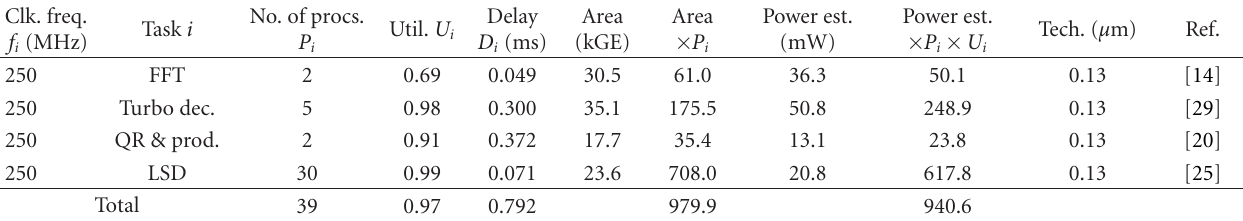
Table 1: The baseband processing chain with TTA processors, 2 × 2 antennas, 1201 subcarriers, 64-QAM, 6144-length turbo code block, list length K = 16, data rate 100Mbps.